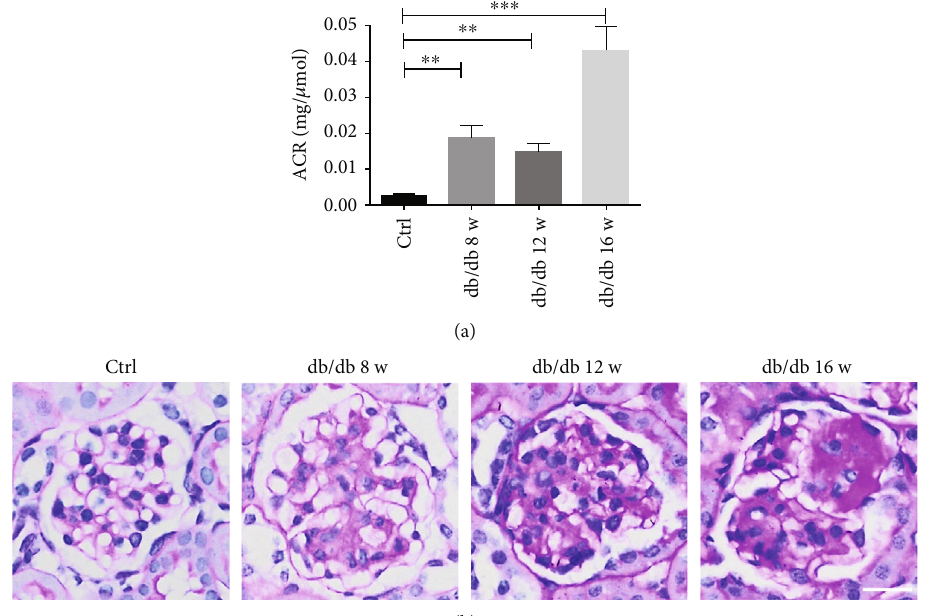
Figure 3: Characterization of db/db mice. (a) db/db mice ( n ≥ 3 ) had signi fi cantly increased urine ACR compared with the control group ( n = 4 ). Data are expressed as mean ± SEM ; ∗∗ P < 0 : 01 , ∗∗∗ P < 0 : 001 for db/db mice by the age of 8 w, 12w, and 16w versus the control group. (b) PAS-stained kidney sections revealed increased glomerular mesangial matrix in db/db mice compared with the control group. Shown are representative images from at least three mice per group with similar results (scale bar: 100 μ m in all images of